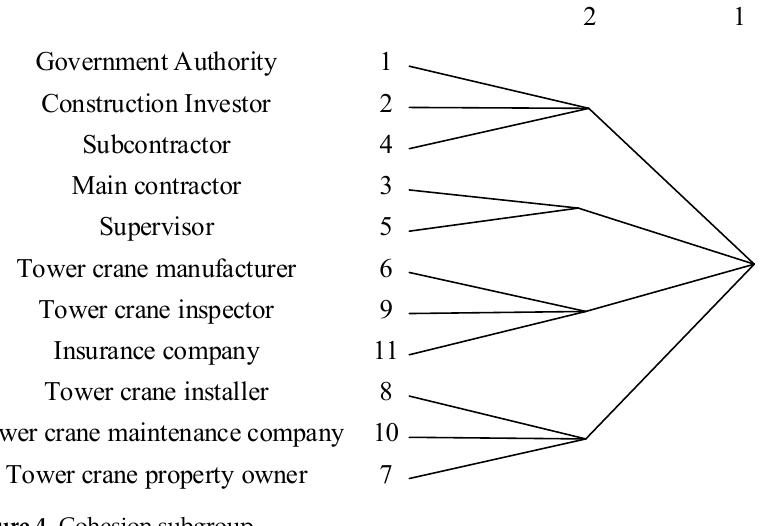
Figure 4. Cohesion subgroup. Table 8. Cohesion subgroup density.